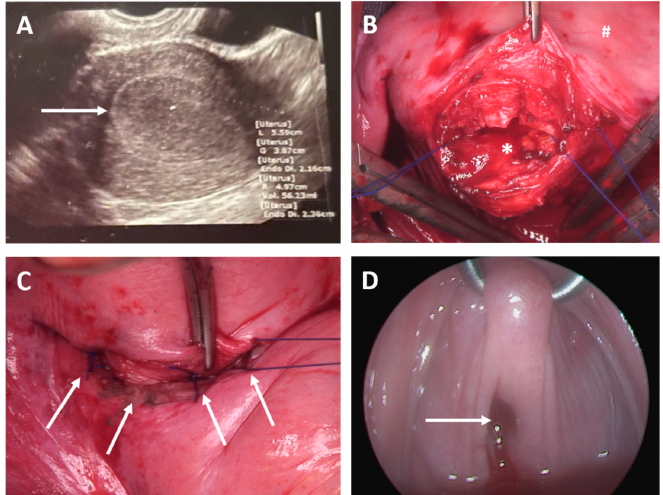
Figure 3. Case 6. ( A ) Transabdominal sonography; uterus with hematometra after weaning from hormonal therapy; arrows show significant hematometra. ( B ) Situs during abdominal